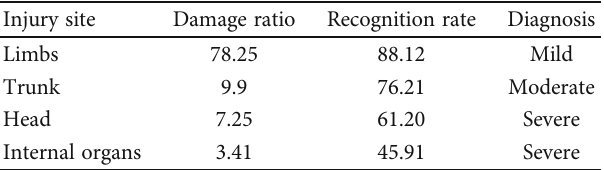
Table 1: Diagnosis of di ff erent injury sites in football.